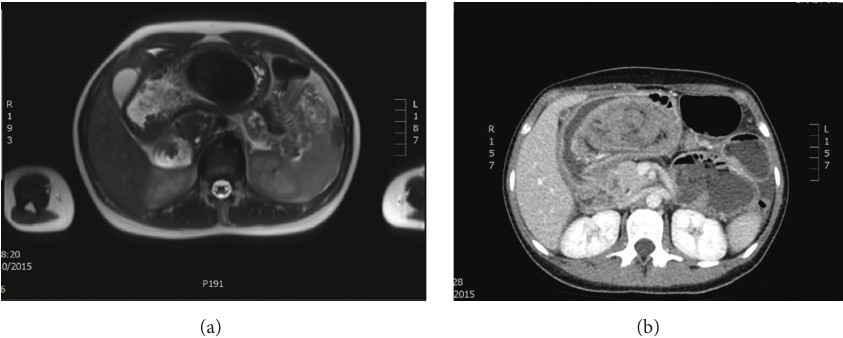
Figure 1: (a) MRI demonstrating two well-defined T2 hypointense and T1 isointense filling defect mass lesions within the stomach, extending into the proximal duodenum. The larger of these within the body of stomach measures approximately 100 × 50mm (appears pedunculated) and the smaller of these in the gastric fundus measures 40 mm. (b) Preoperative CT confirms the presence of the mass in the patient’s stomach.